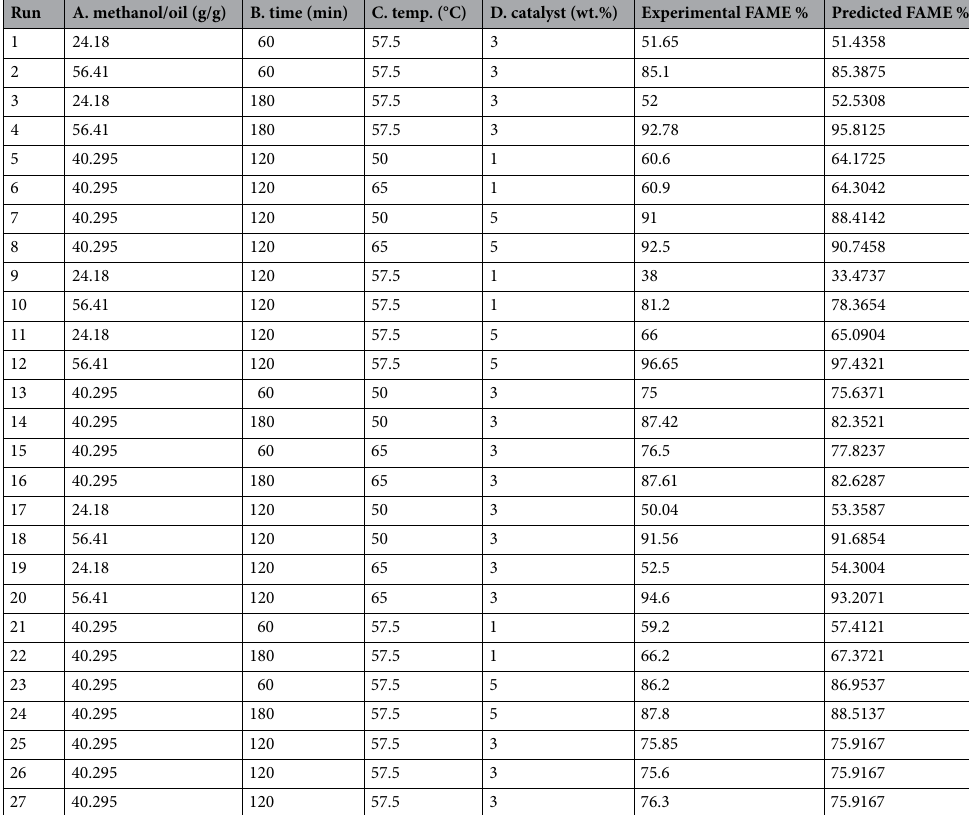
Table 3. Key transesterification reaction parameter optimization with the RSM.